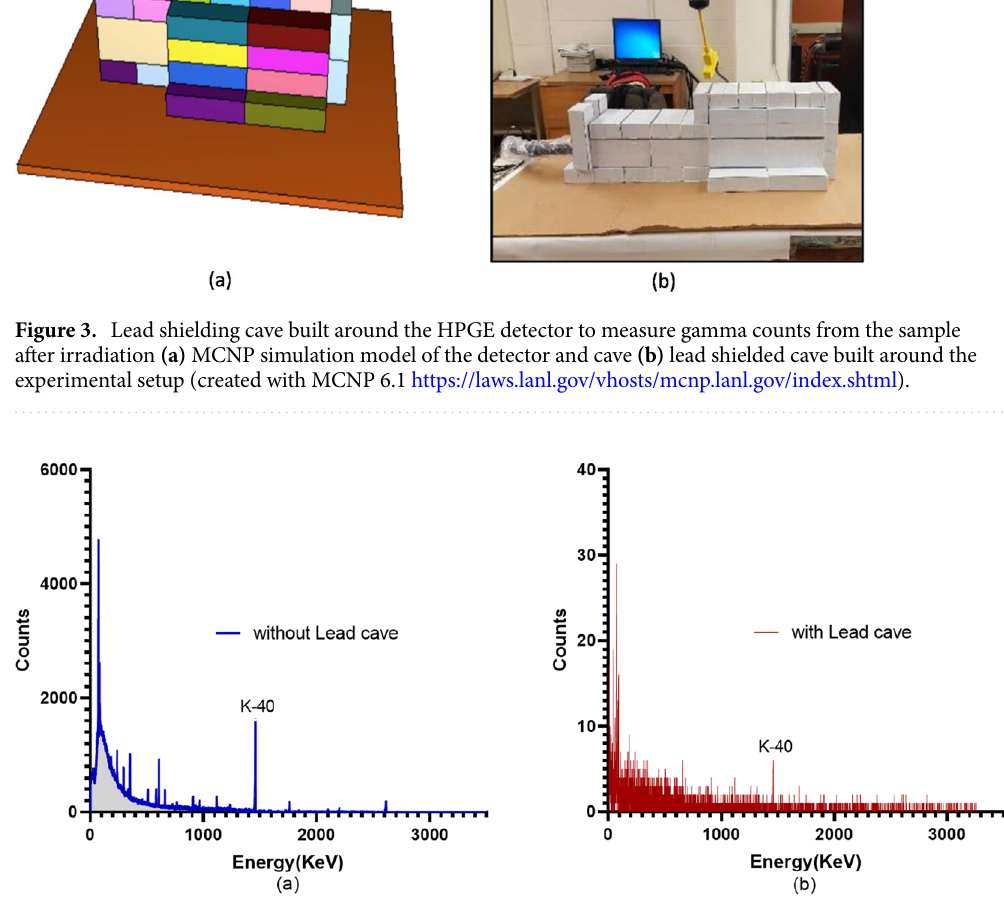
Figure 4. Background radiation spectrum obtained with the HPGe detector without any sample (a) without lead cave and (b) with lead